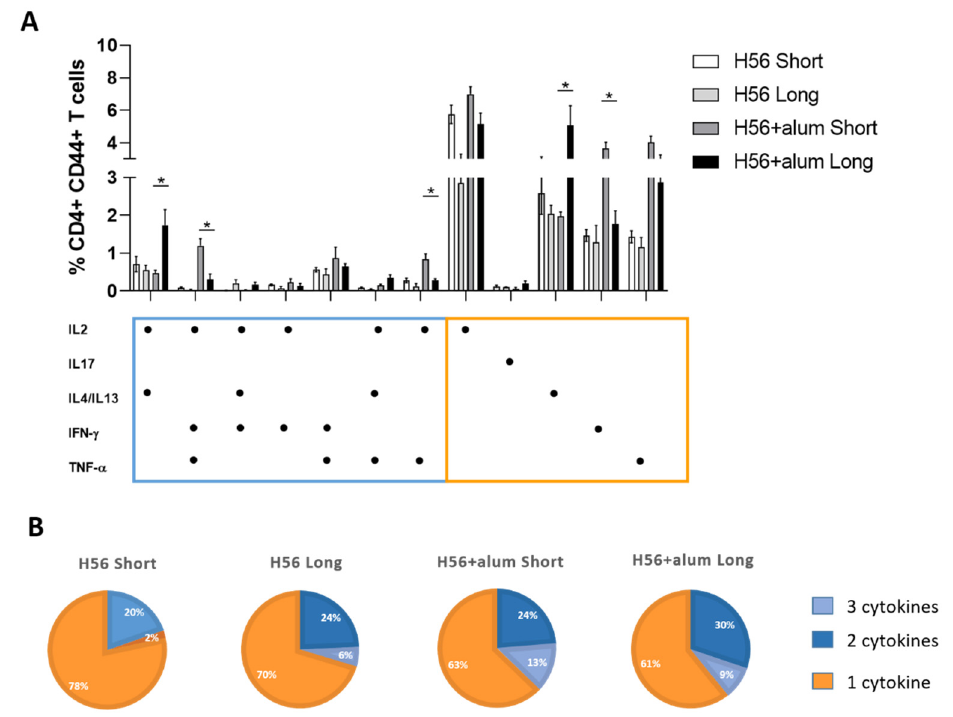
Figure 5. Helper T cell multifunctional response. Multifunctional profiles of CD4+ T cells detected by the different immunization protocols as reported in Figure 1. ( A ) Histograms represent the frequency of CD4+ CD44+ T cells producing different combinations of cytokines after the short and long schedule. Responses are grouped and color-coded according to the functionality (orange for single cytokine, light blue for two or three cytokine production). Values are reported as mean ± SEM of six mice per group. The Kruskal–Wallis test followed by Dunn’s post hoc test for multiple comparison was used to assess statistical differences among groups (* p ≤ 0.05). ( B ) Pie charts represent the portion of CD4+ T cells producing three cytokines (orange), two cytokines (light blue), or a single one (grey). Frequencies are reported within each